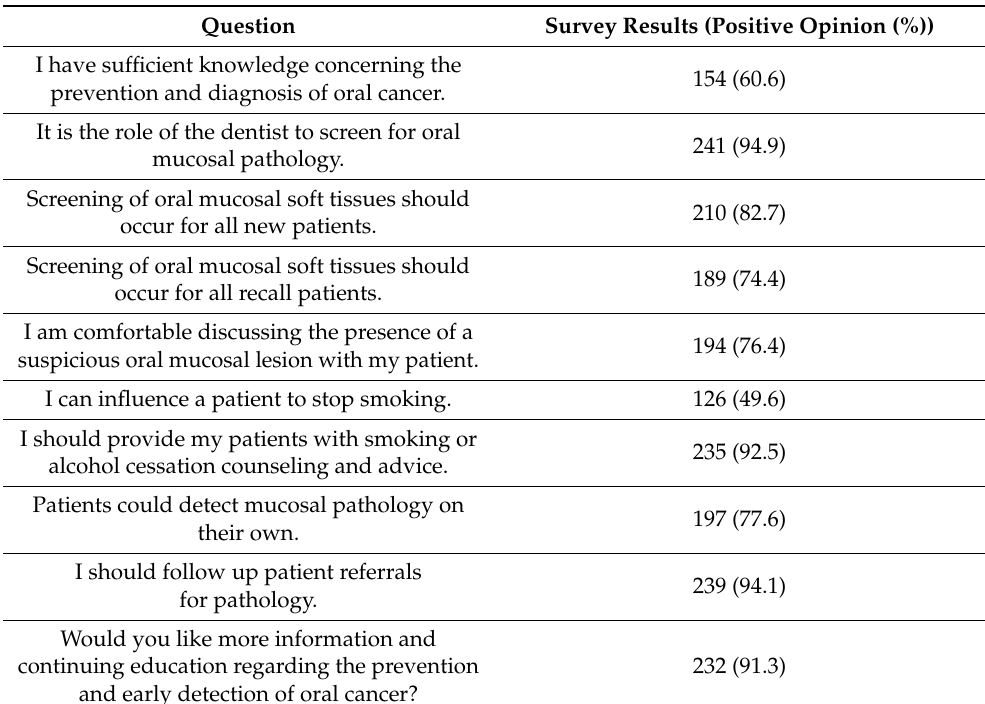
Table 4. Number and percentage of participating dentists who revealed positive opinions related to oral mucosal screening and oral cancer